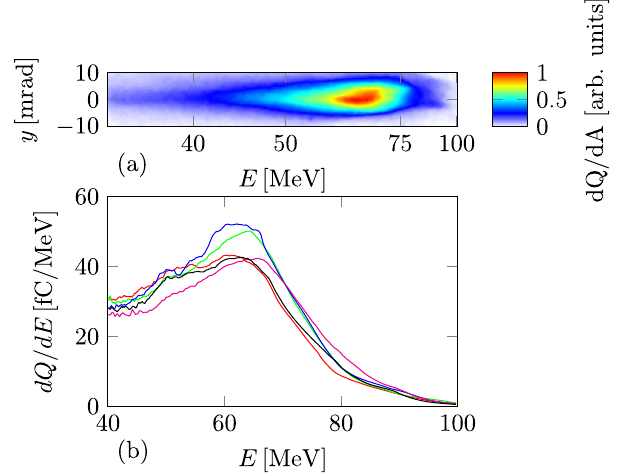
FIG. 2. Typical image of the dispersed electrons impacting on the scintillating screen (a) in a color map representing amount of charge per area. The total amount of charge is approximately 1.5 pC and the beams have a divergence of 10 mrad. Calculated energy spectra of electrons accelerated in five consecutive shots (b). The energy spectra of the electrons accelerated using this target typically contains a broad peak at an energy that is tunable from 50 to 80 MeV. The shot-to-shot fluctuations in charge and average energy achieved using this setup are significantly better compared to